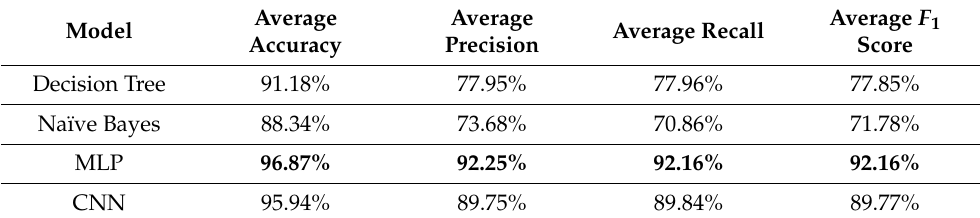
Table 3. Performance comparison among the classifier models used for the proposed hand gesture recognition system. The MLP classifier is the best performing across all performance metrics. Average Model Accuracy